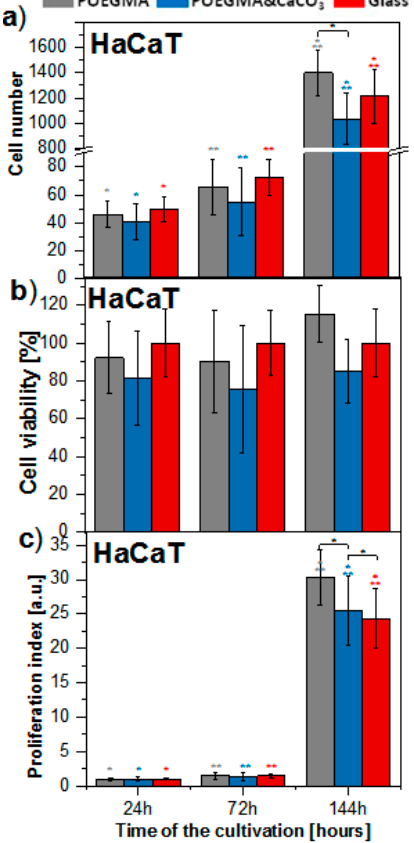
Figure 8. Impact of glass surface, POEGMA and POEGMA-grafted brush coatings with incorporated CaCO 3 NPs on the amount ( a ), viability ( b ) and proliferation index ( c ) of HaCaT cells (*, ** significantly different from each other, p < 0.05). Data are presented as a mean ± standard deviation (SD) from n = 10 repetitions.